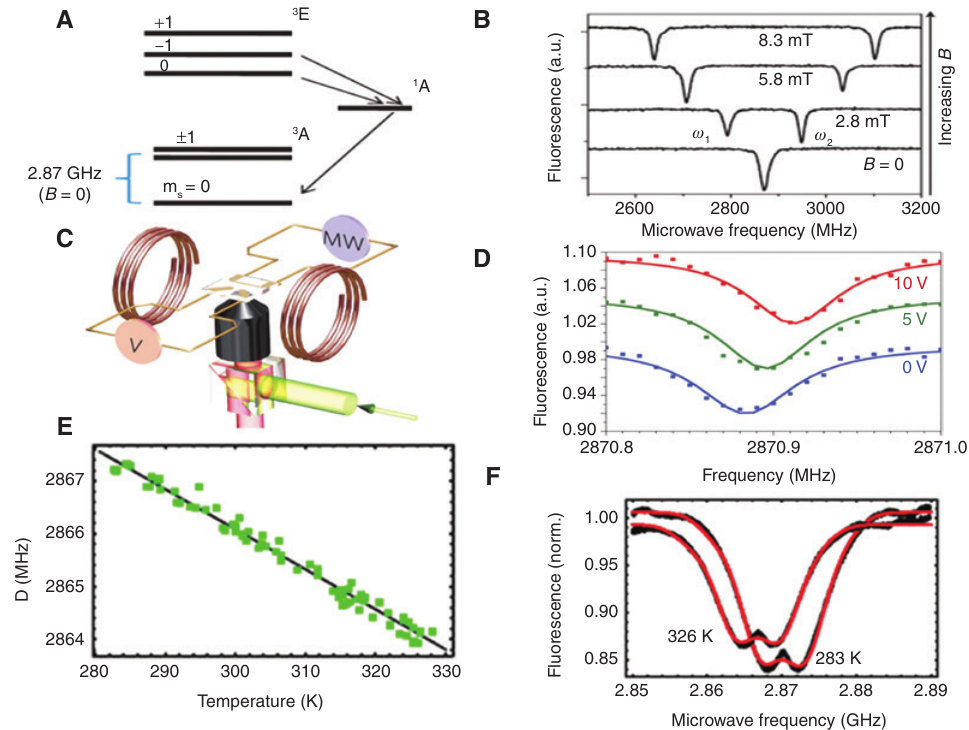
Figure 13: An illustration of FNDs capability in magnetic, electric, and temperature sensing. (A) An illustration of the energy level of the nitrogen-vacancy (NV) defect in diamond. (B) Optically detected magnetic resonance spectra (ODMR) for a single nitrogen-vacancy defect at increasing magnetic field (from bottom to top). Adapted from [144]. (C) Schematic of the confocal set-up used with Helmholtz coils for magnetic field alignment and a microstructure on the diamond sample to create the electric field and coupled with the microwaves. Adapted from [140]. (D) Observed shift of the ODMR resonance lines for different voltages applied to the electrodes, clearly showing the effect of a Stark shift. Adapted from [140]. (E) A linear fit of the NV center ODMR spectra changes as a function of ambient temperatures. Adapted from [146]. (F) ODMR changes linearly as a function of temperatures from 280 to 330 K. Adapted from